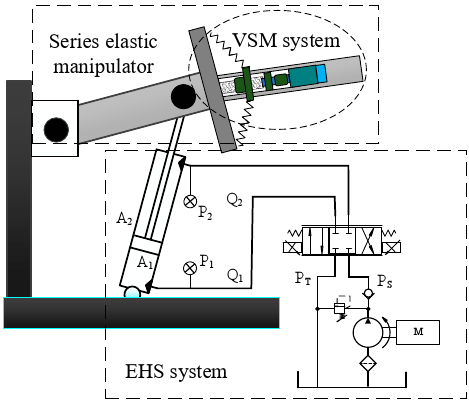
Figure 1. Electrohydraulic elastic manipulator.